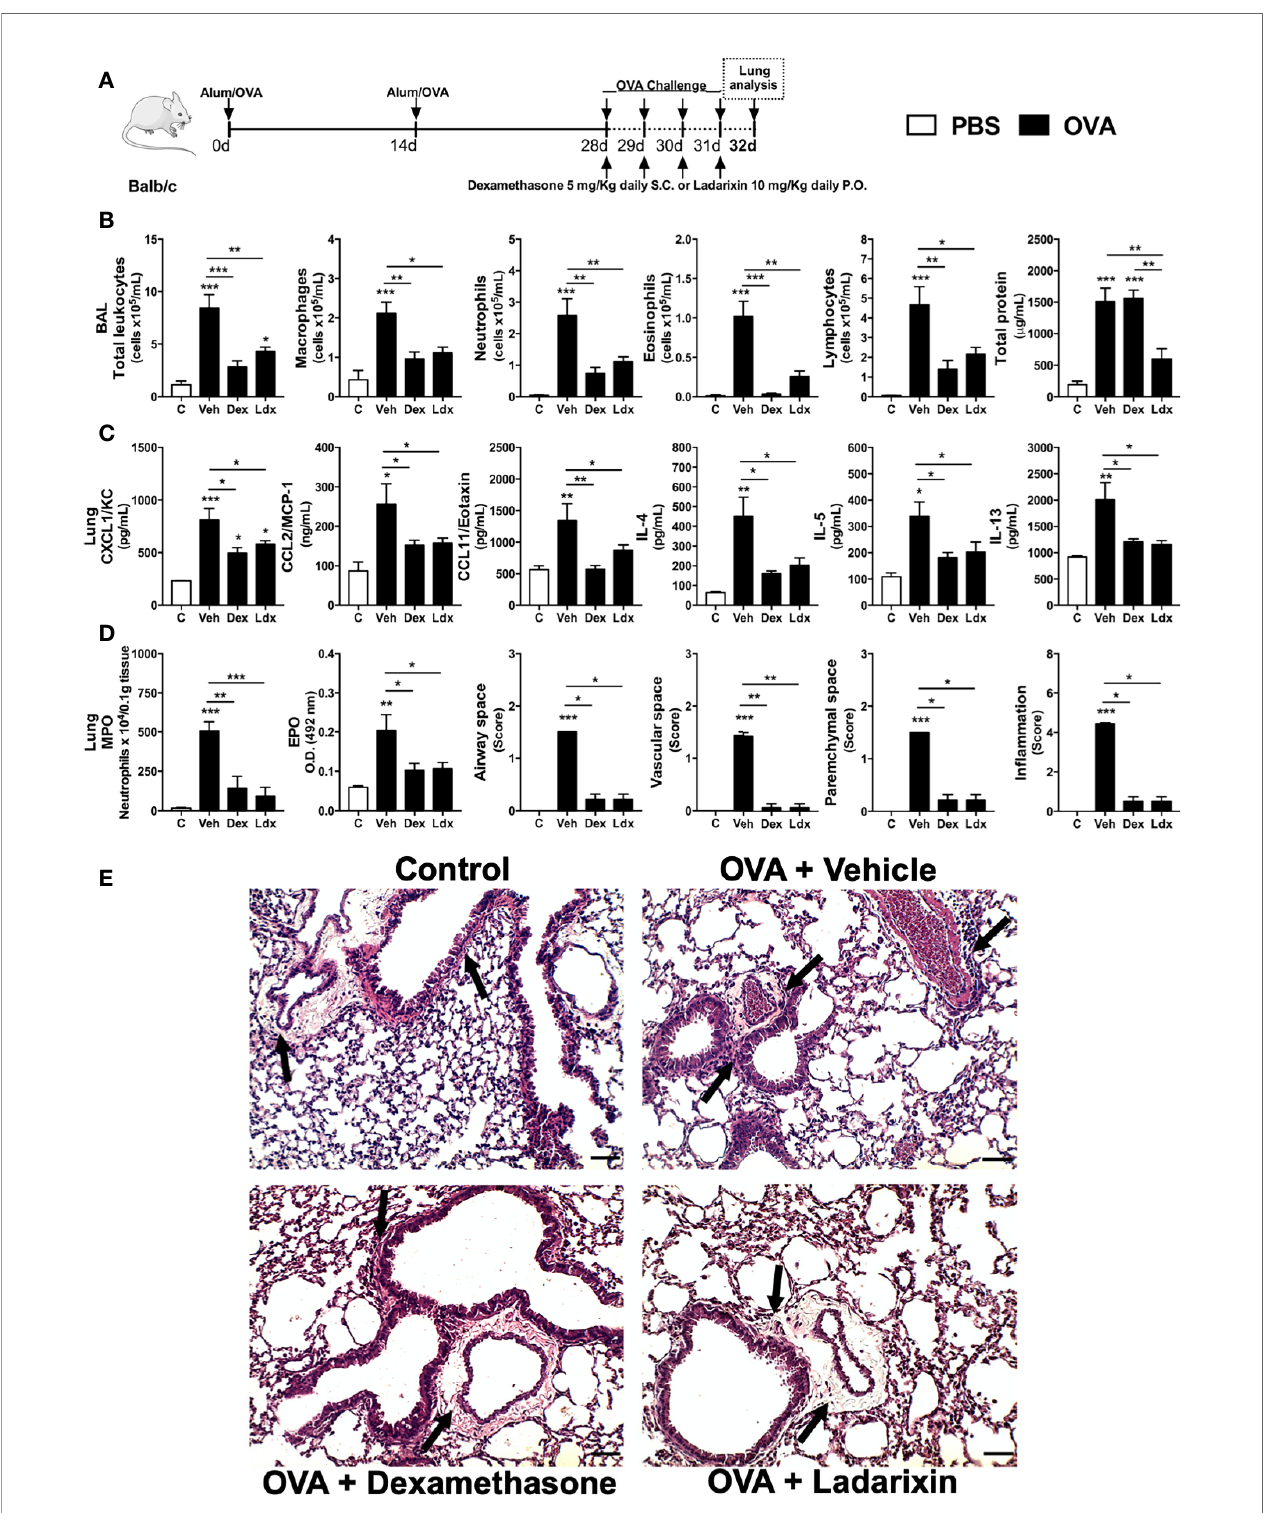
FIGURE 4 | Ladarixin treatment reduces Th2 allergic airway and lung in fl ammation in acute asthma model. In fl ammatory parameters were evaluated after four daily challenges with OVA. (A) Schematic representation of the experimental design. (B) Assessment of leukocyte in fl ux and blood leakage into airways. (C) Chemokine and cytokine levels in lung parenchyma. (D) MPO and EPO activity quanti fi cation and pulmonary in fl ammation score. (E) Histological sections of lung (H&E dye). Arrows indicates peribronchial in fl ammation. n = 8 for each group, * for P < 0.05; ** for P < 0.01 and *** for p <